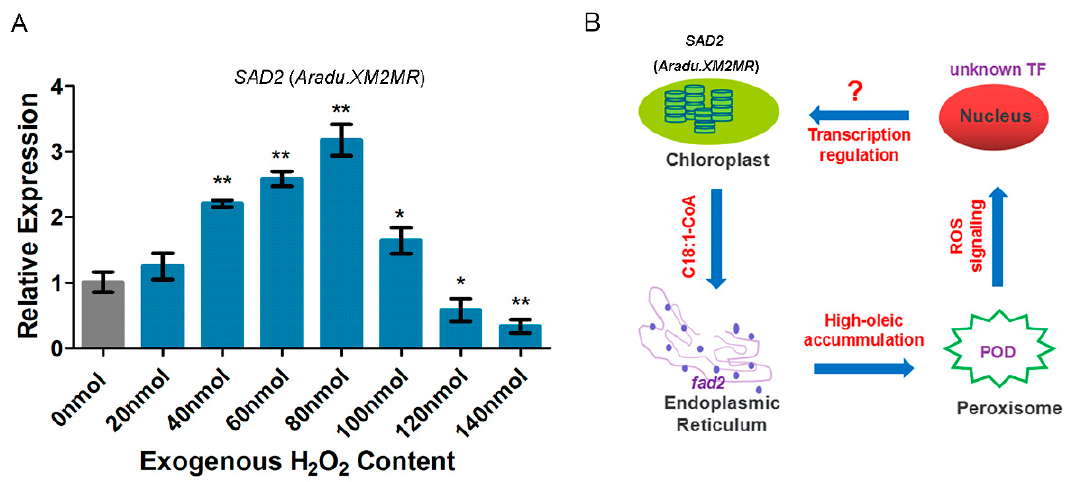
Figure 8. Putative model of FAD2 mutation-induced feedback in regulating the expression of upstream oleic-synthesis gene SAD2 ( Aradu.XM2MR ). ( A ) Examination of SAD2 ( Aradu.XM2MR ) expression level by using the exogenous H 2 O 2 treated the normal-oleic cultivar seedlings. Values shown are means ± SD of three biological replicates, and asterisks indicate a significant di ff erence (* p < 0.05, ** p < 0.01) compared with the control group (0 nmol). ( B ) FAD2 mutation located at the ER membrane. High-oleic accumulation in the peroxisome triggers FA β -oxidation reaction, and then ROS signaling mediates nucleus’s transcription factors (TFs) to regulate the transcription level of chloroplast (or plastid, under dark condition) protein SAD2 ( Aradu.XM2MR ) via an unknown signaling pathway.